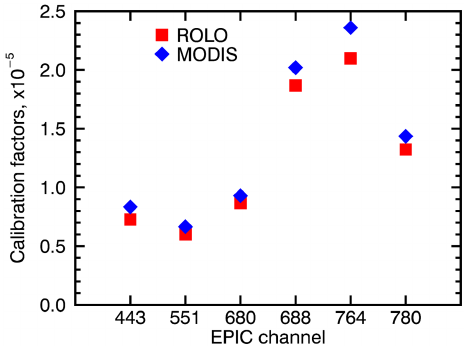
Figure 10. Comparison between MODIS- and ROLO-derived cali- bration